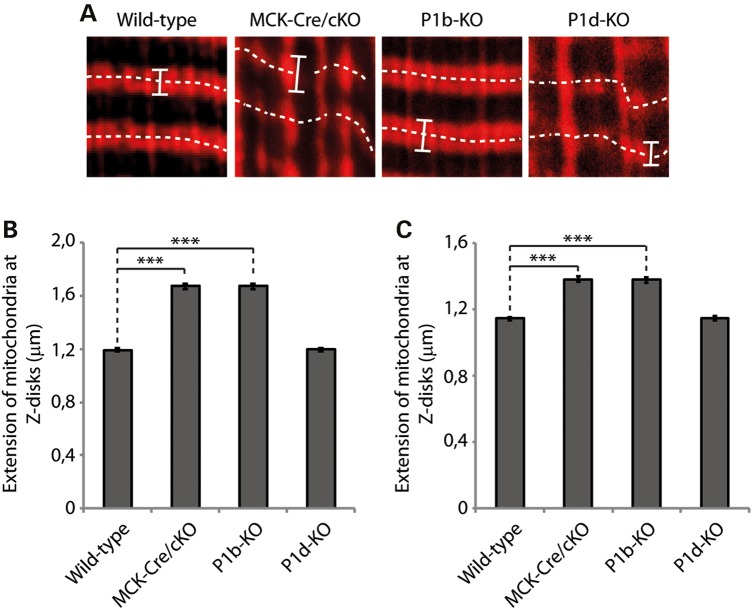
Extension of mitochondrial structures across Z-disk structures in MCK-Cre/cKO and P1b-KO muscles. (A) Gastrocnemius muscles were stained using MitoTracker. Bars mark outer rims of mitochondrial structures wrapped around Z-disks. Dashed lines indicate the orientation and position of Z-disks (compare with Fig. 4C). Note the loss of myofibrillar alignment and disorganization of mitochondrial structures in MCK-Cre/cKO and P1d-KO muscles. (B and C) Statistical analyses of mitochondrial width measurements in gastrocnemius (B) and soleus (C) muscles using ImageJ software. Because of the misalignment of myofibrils in some specimens, particularly MCK-Cre/cKO and P1d-KO muscles, only mitochondria in focus with the optical plane were included in the analysis. Note the increased dimensions of mitochondria in MCK-Cre/cKO and P1b-KO, but not in P1d-KO muscles. Mitochondria from wild-type (n = 131), MCK-Cre/cKO (n = 129), P1b-KO (n = 135) and P1d-KO (n = 132) muscle slices were analyzed in three independent experiments.